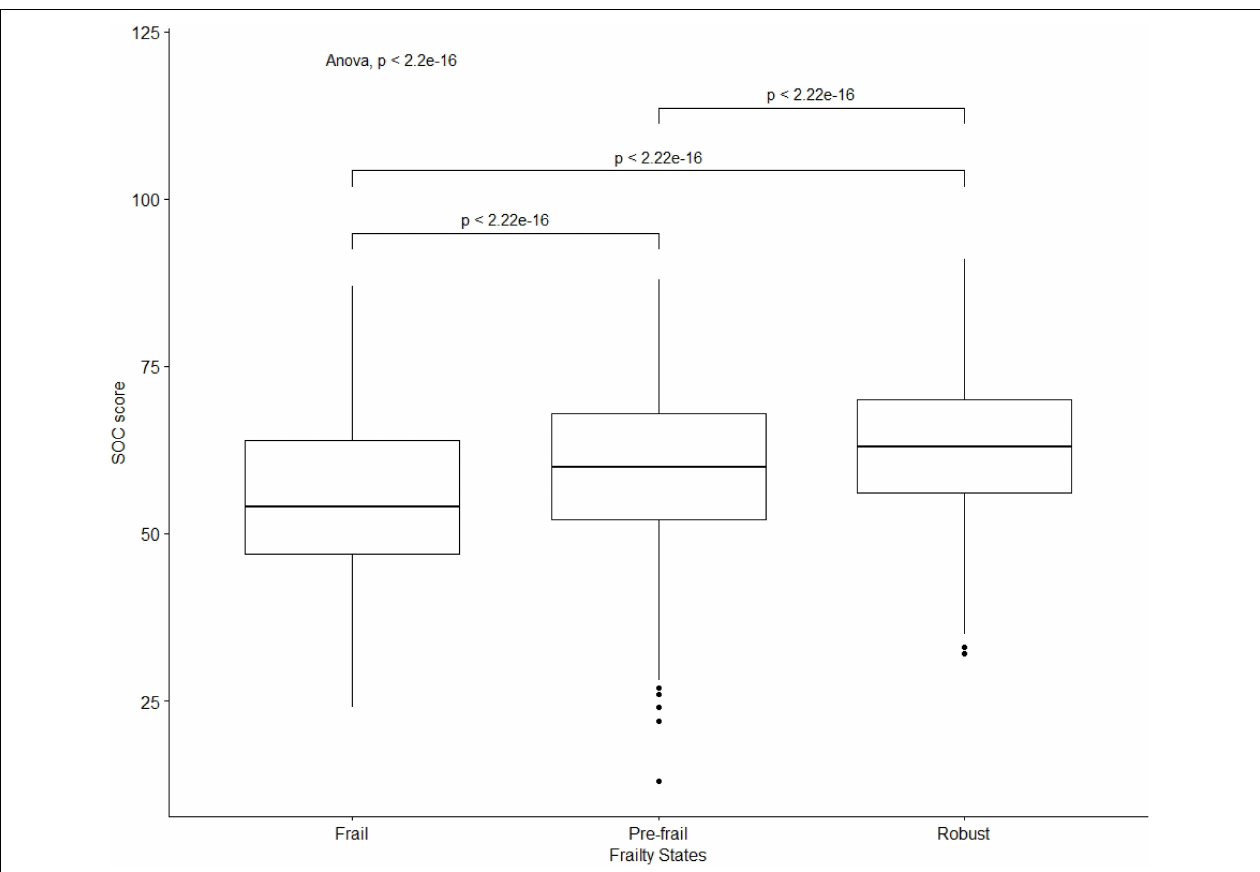
FIGURE 1 | A boxplot of the distribution of SOC score among frail, pre-frail, and robust